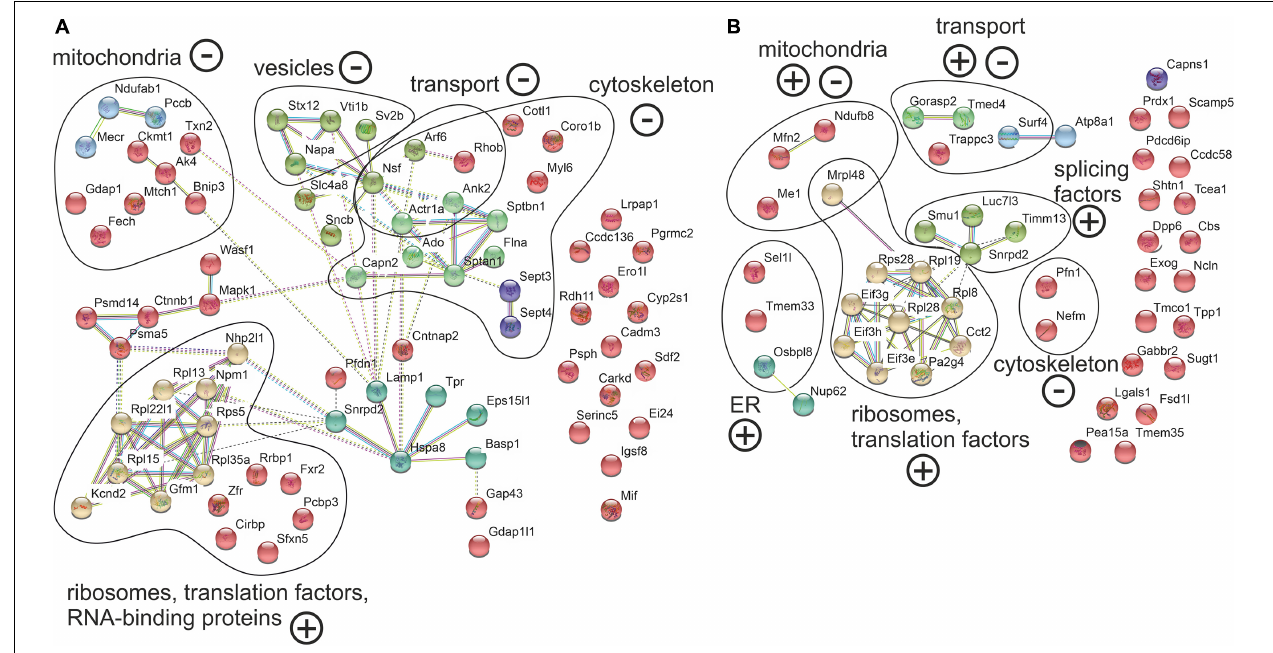
FIGURE 6 | Abnormal localization between axon and soma in the cerebellar and cortical neurons of Ki91 SCA3/MJD build an intensely interconnected network of proteins of translation machinery, vesicles, and transport machinery, cytoskeletal and mitochondrial proteins. The network of proteins displaying altered ratio between axon and soma in cerebellar (A) and cortical neurons (B) of Ki91 mice were generated using String database and clustering (https://string-db.org/). Number of proteins enriched in cerebellar axons n = 34 (ratio axon/soma > 1, p < 0.05; two-sample t -test); reduced in cerebellar axons n = 41 (ratio axon/soma < 1, p < 0.05; two-sample t -test); enriched in cortical axons n = 27 (ratio axon/soma > 1, p < 0.05; two-sample t -test); reduced in cortical axons n = 20 (ratio axon/soma < 1, p < 0.05; two-sample t -test), four biological replicates per genotype. Distinct colors denote clusters of proteins generated by the String algorithm, which grouped functionally associated proteins into specific sets, such as translational machinery (ribosomes and translation factors), cytoskeletal-modulators, and vesicular proteins. Functional groups are marked and named based on GO annotations (BP, M Level 3, 4, and 5; q < 0.01) using CPDB or GO term search if not available in CPDB. “+” and “–“ denote for enrichment or depletion of protein groups in axons based on F.C. of the majority of proteins in the group. Blue and pink edges represent known interactions, green, red, and dark blue represent predicted interactions, while black and purple are other